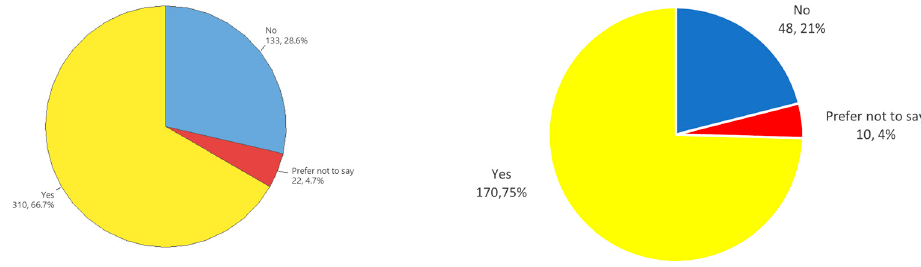
Figure 2. Religion or personal spiritual practices (Q4); whole group (465) ( Left ) + subset (228) ( Right ).